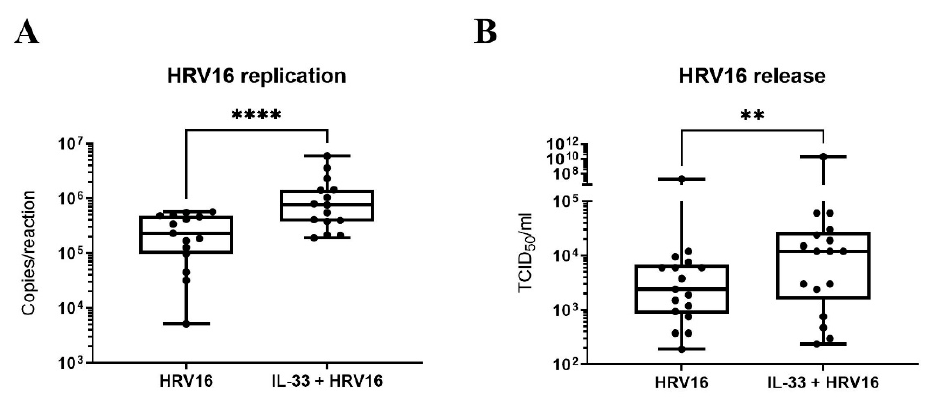
Figure 4. IL-33 enhances HRV16 replication and virion release in MCs. Viral RNA ( A ) and virion release ( B ) in LAD2 MCs pretreated with or without IL-33 (10 ng/mL) for 24 h prior to HRV16 infection (MOI 7.5) for a further 24 h, n = 15. ** p ≤ 0.01, **** p ≤ 0.0001 for HRV16 versus IL- 33+HRV16.